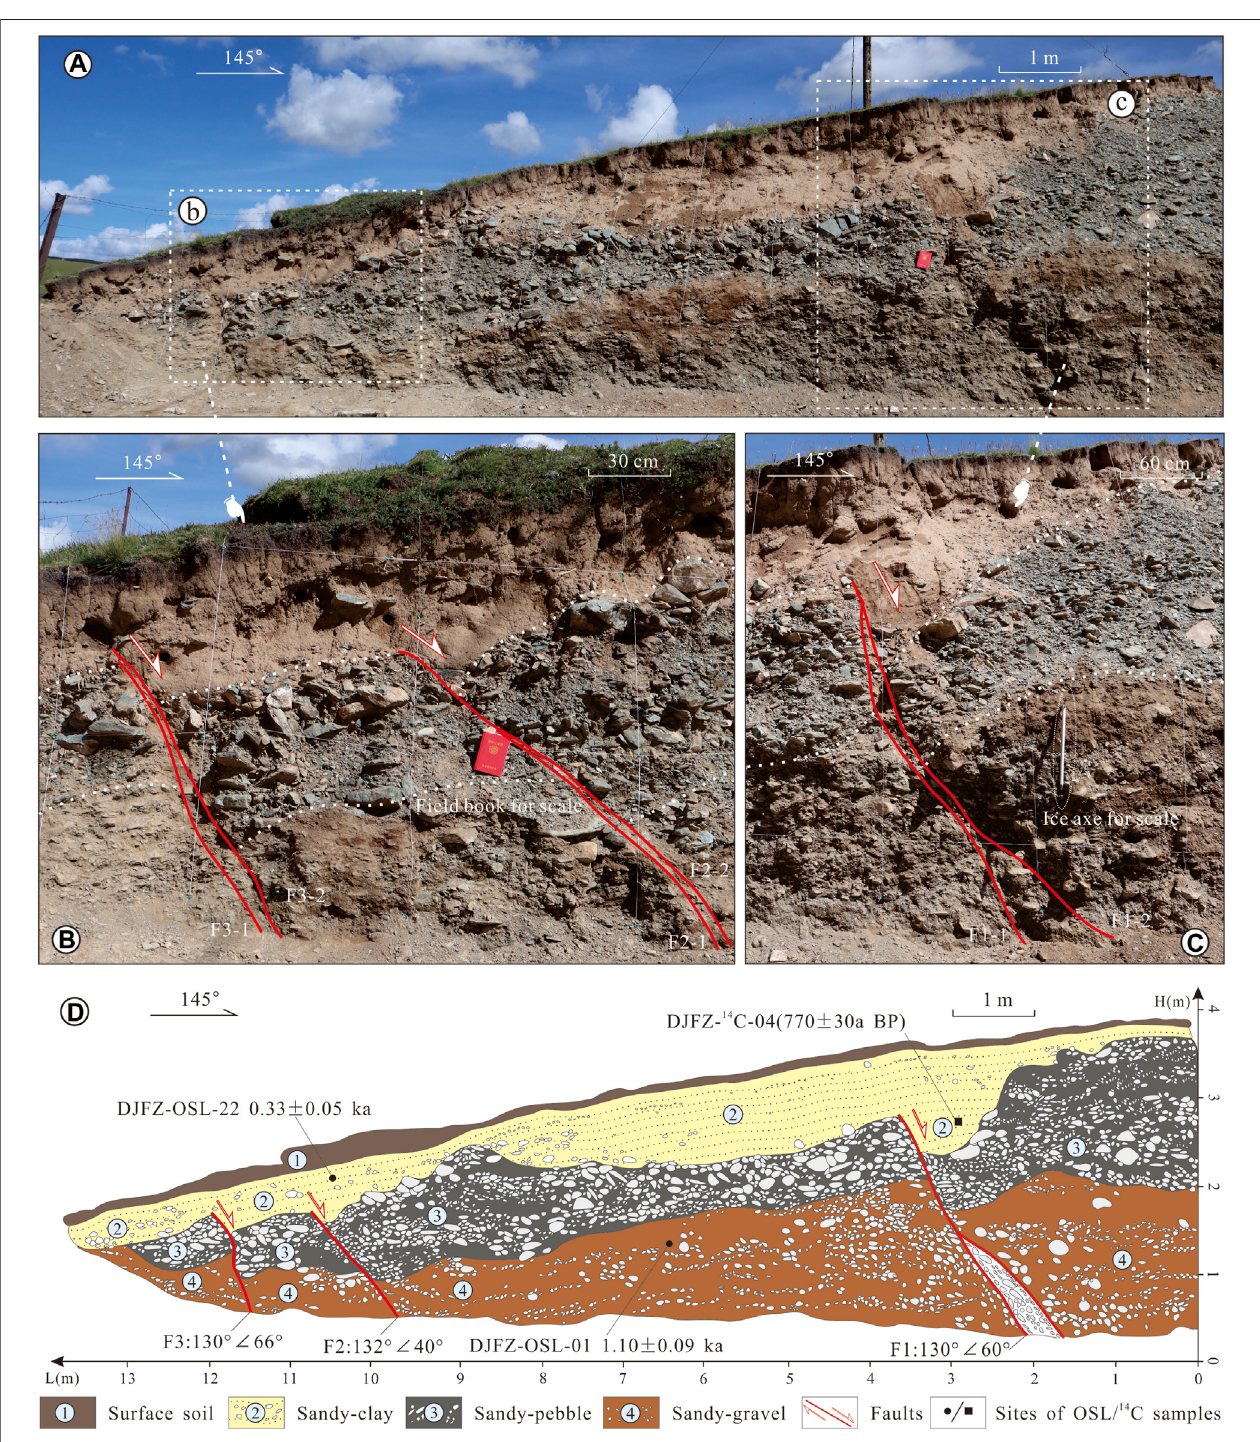
FIGURE 8 | Trench excavated near the east of Riqing village on the middle section of the DJF, and the site of the study point is marked in Figure 3 M. (A) Original east wallofthetrench;photographs (B,C) areenlargedmapsof (A) .Redlinesinthemap indicatethefaulttraces; notetheiceaxis inthemapforscale; (D) interpretation mapofthewestwall.FaultsF1,F2,andF3cutthesedimentsofUnitsfourtotwoandareoverlainbyUnit1.Threechronologicaltestresultsatthispointhintthatthelatest rupture should occur in the CE 1738 Dangjiang historical earthquake with an accumulated co-seismic offset of ~0.9 m (see the text for details).